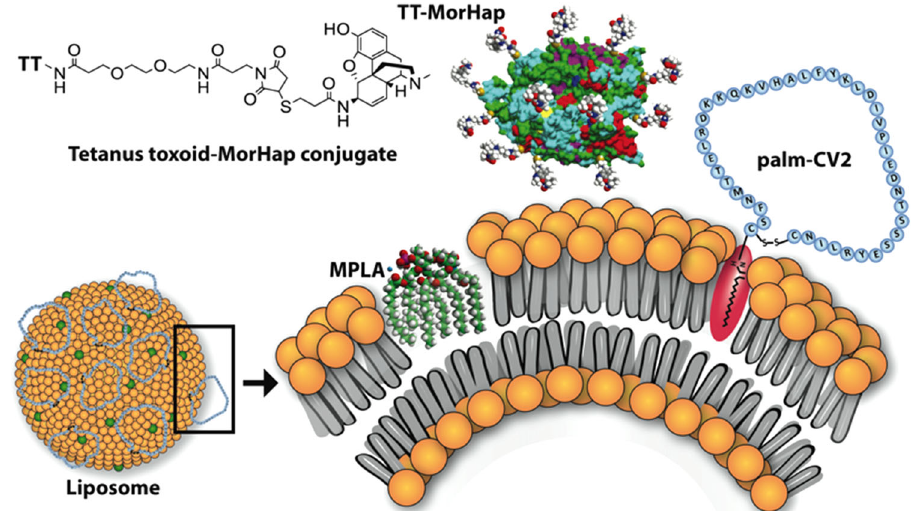
Fig. 1 Schematic illustrations of combination vaccine formulations used for immunization of mice to induce antibodies to cyclic V2 peptide and MorHap. The palmitoyl moiety of palm-CV2 anchored the peptide to the lipid bilayer. MorHap (heroin hapten) was coupled to TT to yield TT-MorHap. The TT-MorHap and palm-CV2 was mixed with ALF, which served as an adjuvant. The entire TT was used for coupling with MorHap, but for simplicity the graphic illustrates the 2.3 Å X-ray crystal structure of tetanus neurotoxin light chain obtained from the RCSB Protein Data